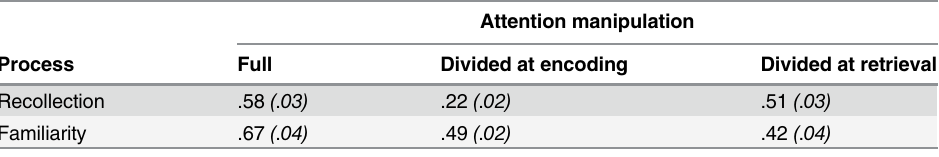
Table 2. Experiment 2. Mean estimates (and SE) of Recollection and Familiarity hit rates, as a function of Attentional: Full, divided at encoding, and divided at retrieval. Attention